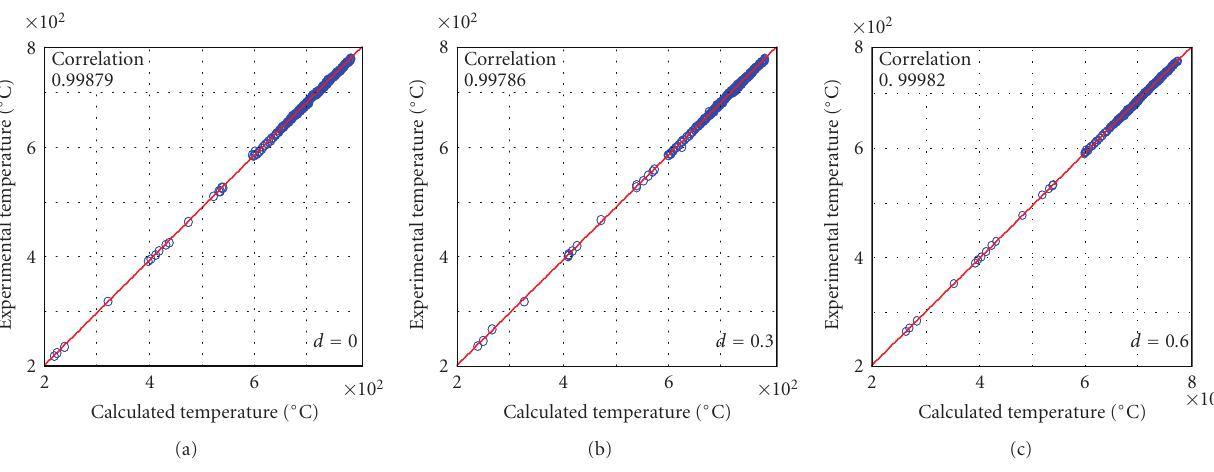
Figure 9: E ffi ciency of the neural networks for the tempering steel 50CrMo4.